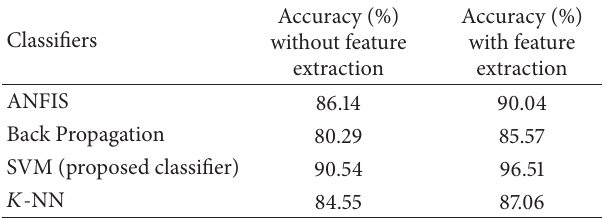
Table 6: Classification accuracies based on feature